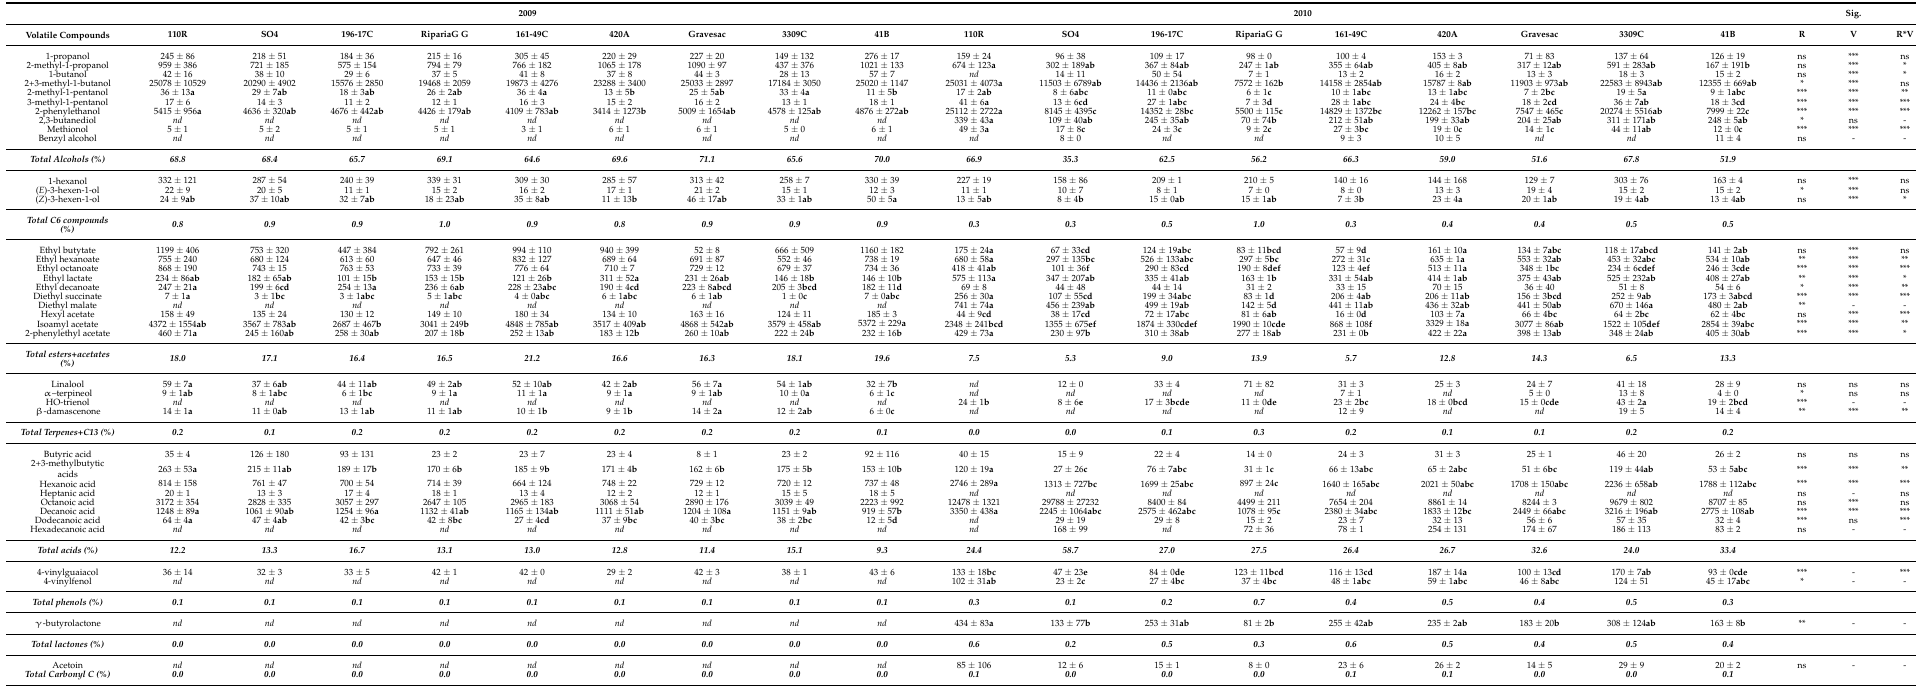
Table 4. Volatile composition ( µ g/L) of Albariño wines from different rootstocks (R) over two vintages